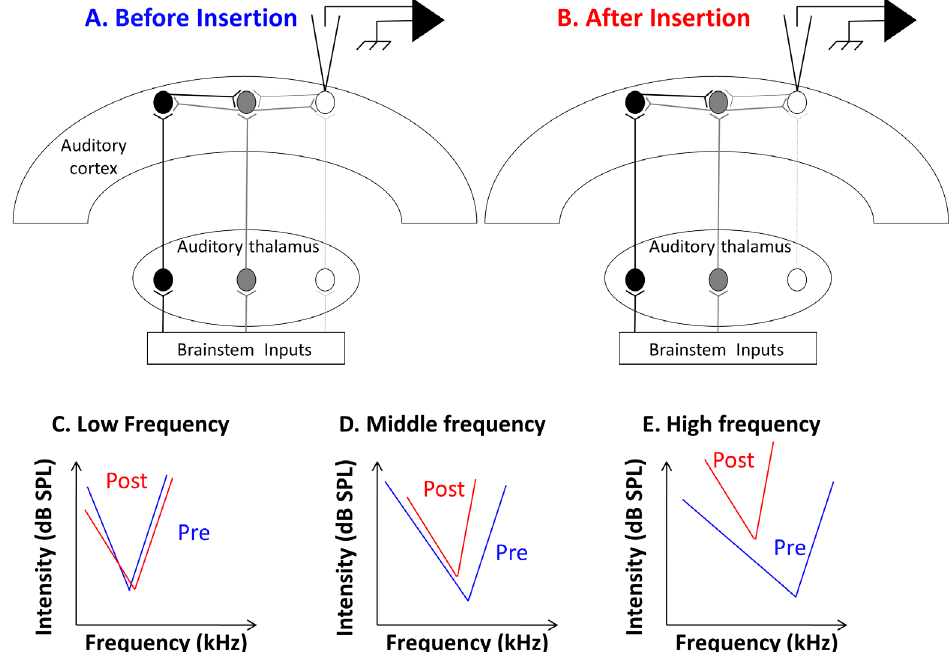
Figure 6. Schematic representation of the potential mechanisms involved in the effects detected after CI insertion. ( A ) In the auditory cortex, a given cortical neuron recorded in the high frequency region, receives thalamic inputs but also cortico-cortical inputs from other cortical regions. For each cortical neuron, the inputs from the auditory thalamus provide the lowest threshold at the CF, but, at suprathreshold level, the cortical inputs also contribute to the frequency response area (FRA, see [31]; review in [32]). ( B ) After cochlear implant insertion, different mechanical damages made by opening the bulla and performing the cochleostomy around the round window generate a partial loss of synaptic inputs in the high frequency range (indicated by the lack of brainstem inputs in the region). This contributes to an increase in the threshold at the pre-insertion CF. The additional cortico-cortical inputs now provide a new CF (in the middle frequency range) with a higher threshold. ( C – E ) Schematic diagrams illustrating the consequences on the FRA of cortical neurons in the low, middle, and high frequency range. The low frequency neurons do not show an increased threshold and CF shift ( C ). The middle frequency neurons show some increase in the threshold and some CF shift toward lower frequencies ( D ). The high frequency neurons show a large increase in the threshold and large CF shifts toward lower frequencies ( E ).